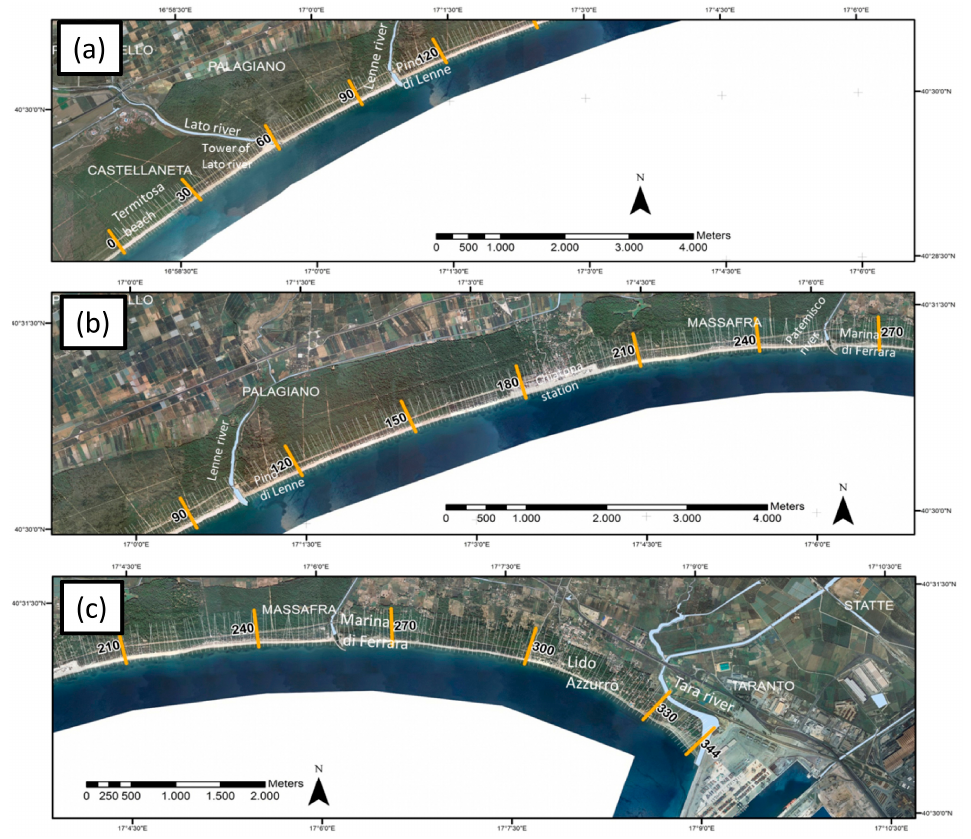
Figure 7. Coastal stretches analyzed in this study. Each transect is reported in the figures; ( a ) CS1 from the Pino di Lenne beach to the Castellaneta beach; ( b ) CS2 from the Marina di Ferrara beach to the Pino di Lenne beach; and ( c ) CS3 from the Tara River mouth to the Lido Azzurro beach.